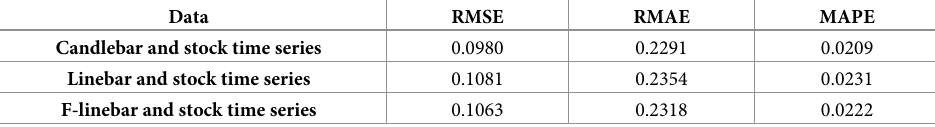
Table 5. Comparison of out-of-sample results for stock chart images and stock time series data using the feature fusion LSTM-CNN model.